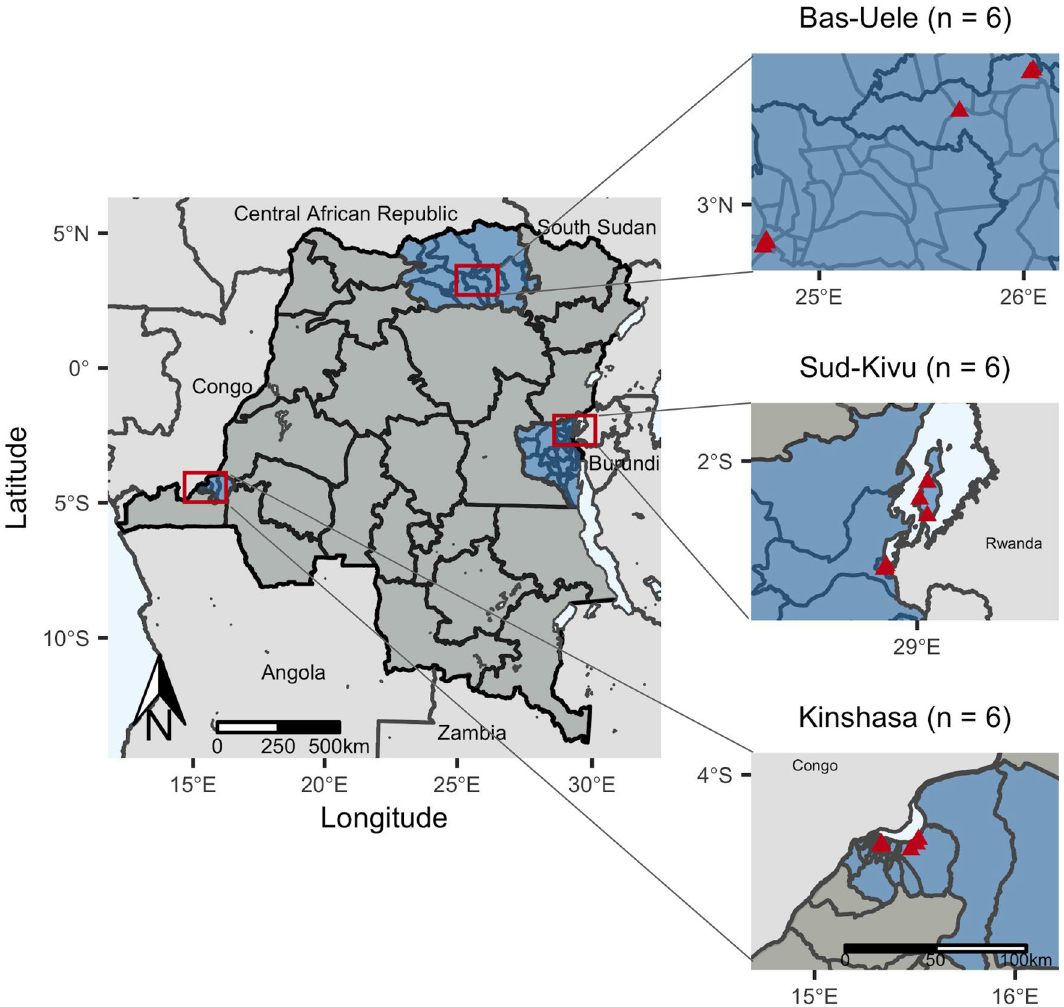
Figure 1. Study sites included health facilities in eighteen health areas (triangles) in six health zones located within three provinces (n = number of facilities per province). Health areas in close proximity have overlapping points. Maps of study sites were rendered in R (R Core Team, Vienna, Austria, 2019, www.R- proje ct. org; version